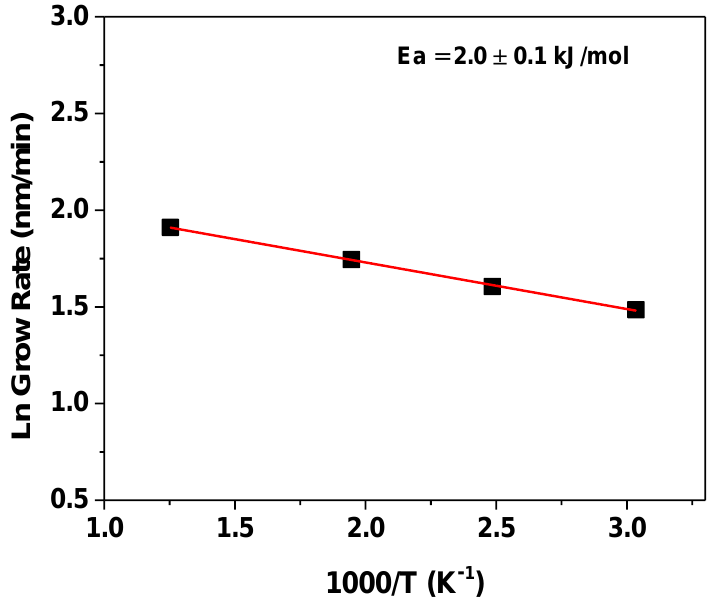
Figure 3. Arrhenius plot of the dependence of the logarithm of growth rate vs. 1000/T. Solid line is the linear best fit.